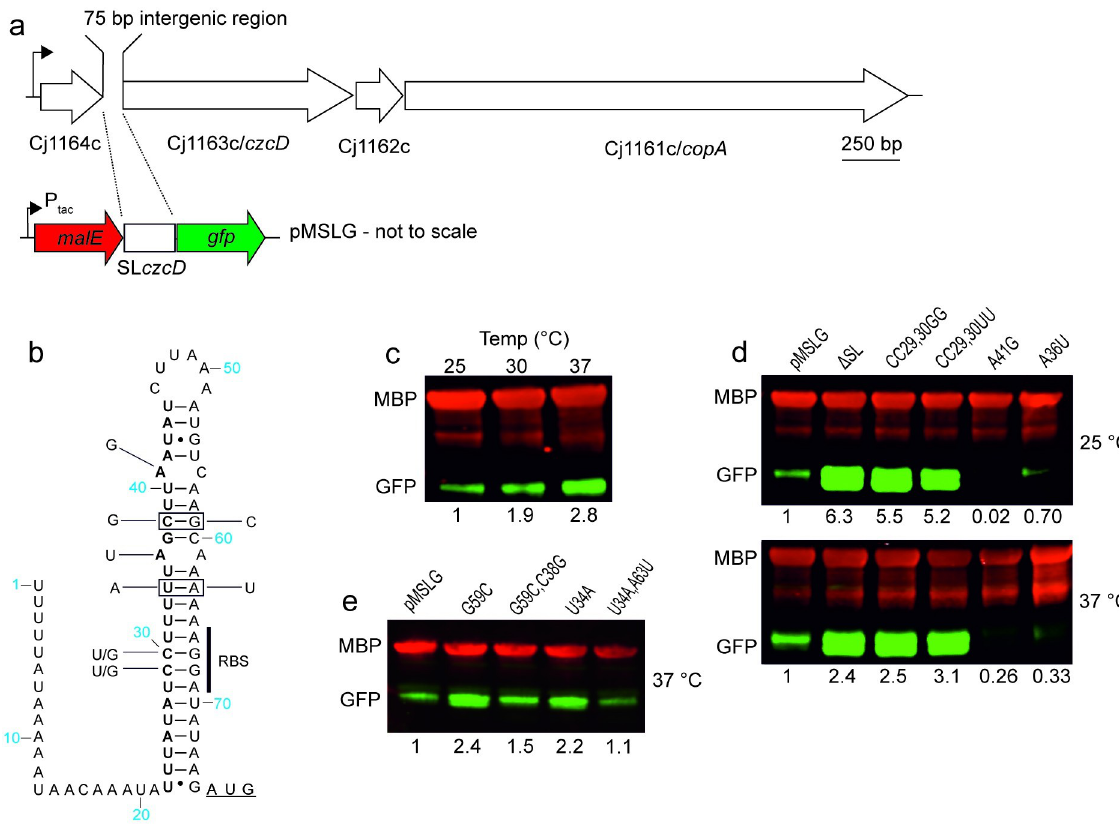
Fig 1. The Cj1164c/Cj1163c intergenic region mediates temperature dependent regulation of a downstream gene in E . coli . a. Diagrammatic representation of the C . jejuni NCTC 11168 operon containing the Cj1163c/ czcD gene with the shaded arrowhead indicating the associated σ 70 promoter identified by RNAseq analyses [36,37].Located between Cj1164c and czcD is a 75 bp untranslated intergenic region (SL czcD ) that was cloned between reporter genes malE (red) encoding maltose binding protein and gfp (green) on plasmid pMSLG downstream of the inducible tac promoter P . b. Predicted SL czcD secondary structure from Mfold analysis with the czcD start codon tac underlined and ribosome binding site (RBS) indicated. Site directed mutations predicted to enhance (A41G and A36U) or disrupt (CC29,30GG and CC29,30UU) secondary structure are indicated, whilst bases in bold indicate the region removed in the pMSLG Δ SL construct. Boxed base pairs indicate where disrupting and subsequent compensatory mutations were introduced as indicated. c. E . coli pMSLG-containing cells were grown at 25, 30 or 37˚C and standardised whole cell lysates western blotted and probed with anti-MBP (red) and anti-GFP (green) antisera. All GFP signals were standardised to the corresponding internal loading control MBP signal and normalised to the 25˚C value. Relative GFP quantifications are provided below the blots. These data are representative of at least three replicate experiments. d. Similar analyses as (c) with extracts from strains containing variants of pMSLG. The pMSLG Δ SL plasmid had the bases in bold in (b) removed. The CC29,30GG; CC29,30UU; A41G and A36U derivatives are as indicated in (b). All GFP signals were standardised to the corresponding internal loading control MBP signal and normalised to the pMSLG value. Relative GFP quantifications are provided below the blots. These data are representative of at least three replicate experiments. e. Similar analyses as (c) with compensatory mutants (boxed in b) in the predicted stem region of SL czcD on pMSLG. The SL czcD G59:C38 predicted base pair was disrupted by introducing a G59C mutation and base pairing restored with a C38G mutation. In a similar manner the U34:A63 predicted base pair was disrupted with a U34A mutation and restored with an A63U mutation. All GFP signals were standardised to the corresponding internal loading control MBP signal and normalised to the pMSLG value. Relative GFP quantifications are provided below the blots. These data are representative of at least three replicate experiments.